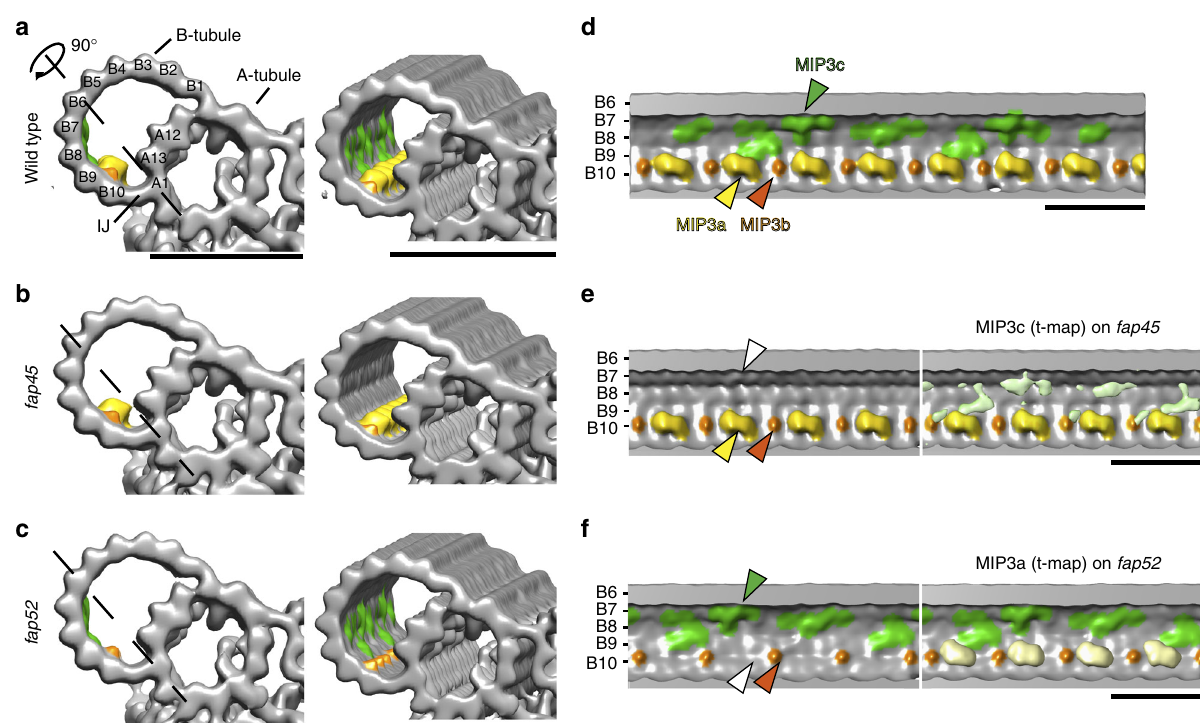
Fig. 3 fap45 and fap52 mutant have structural defects in B-tubules. Isosurface renderings of averaged axonemal 96-nm repeats from wild type ( a , d ), fap45 ( b , e ), and fap52 ( c , f ). ( a – c ) are cross-sectional and oblique, and ( d – f ) are longitudinal views. The black dashed lines in ( a – c ) indicate the slicing plane of ( d – f ). Proto fi lament numbers are labeled in ( a ) and ( d – f ). Missing structures in fap45 and fap52 were determined by Student ’ s t -tests as previously described 33 . The t -value maps acquired by the t -tests were overlaid on the renderings of fap45 ( e , light green) and fap52 ( f , light yellow). In this fi gure, MIP3a and b were colored by yellow and orange, respectively. MIP3c (the missing structure in fap45 ) was colored by green, according to the t -value map shown in ( e ). Scale bar = 25 nm